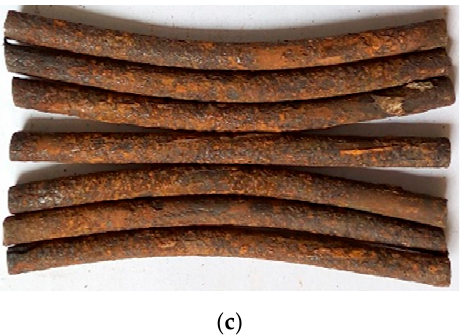
Figure 3. Corrosion morphology of strand: ( a ) Pitting and crevice corrosion; ( b ) crevice corrosion; and ( c ) wire corrosion.